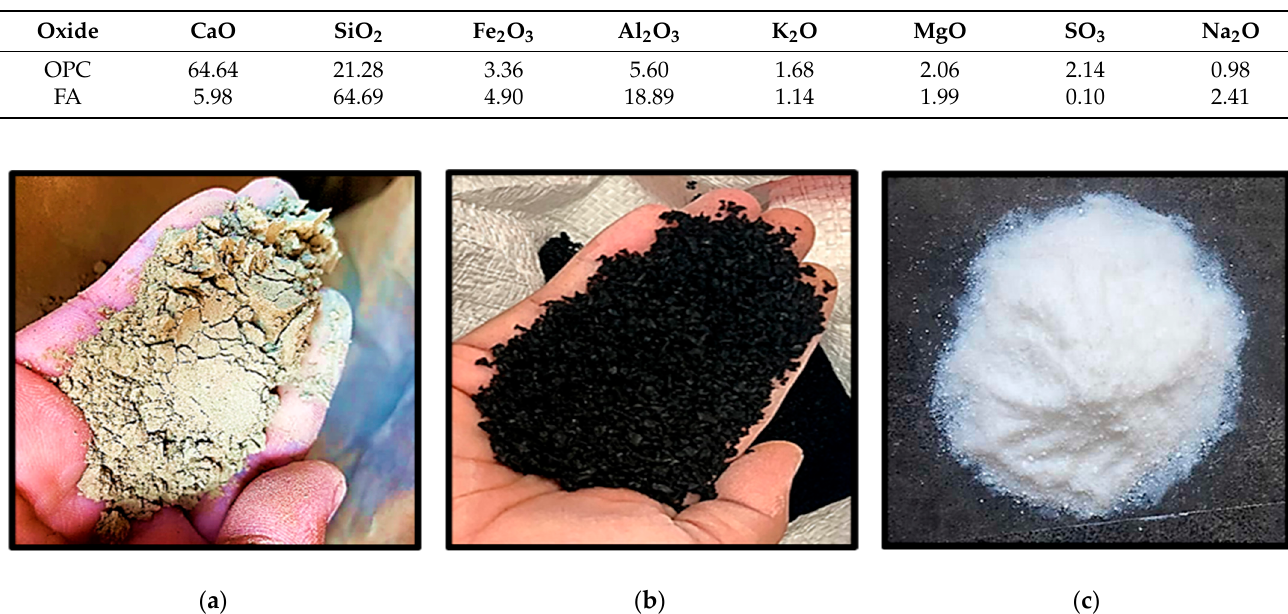
Figure 1. ( a ) Grading of aggregates and CR; ( b ) XRD pattern of nanosilica. Table 2. Oxide composition of the OPC and FA used. Table 2. Oxide composition of the OPC and FA used. Table 1. Physical properties of aggregates and CR.